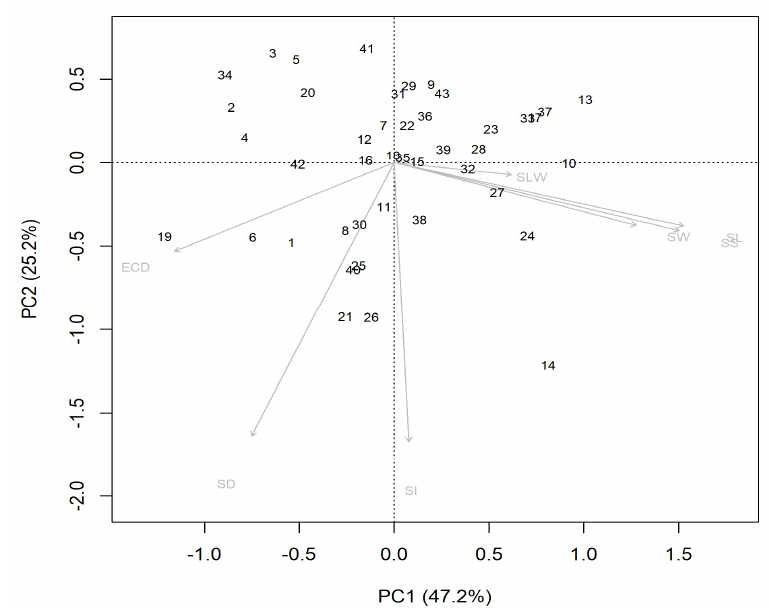
Figure 4. Principal component analysis considering leaf morpho-anatomical traits: ECD, epidermal cell density (cells mm − 2 ); SI, stomatal index (%); SD, stomatal density (unit mm − 2 ); SS, stomatal size (stomatal length × stomatal width); SL, stomatal length (major axis; μ m); SW, stomatal width (minor axis; μ m); SLW, stomatal length/width of 43 Coffea canephora genotypes.